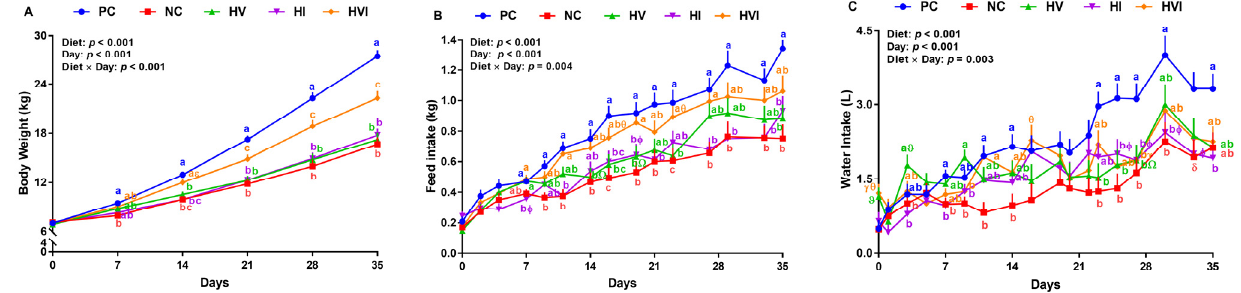
Figure 1. ( A ) Body weight, ( B ) feed intake, and ( C ) water intake of nursery pigs fed with very low protein diets containing isoleucine (Ile), valine (Val), or mix of both above NRC levels. PC: positive control, standard protein diet; NC: negative control, very low protein diet containing the first four limiting amino acids (i.e., lysine, methionine, threonine, and tryptophan) at NRC levels; HV: NC containing Val above NRC level; HI: NC containing Ile above NRC level; and HVI: NC containing both Val and Ile above NRC level. The values are means ± standard error of the mean. n = 8. a,b,c,ab the means with different superscript letter(s) at each time point are different ( p ≤ 0.05). δ p ≤ 0.1 PC vs. NC,